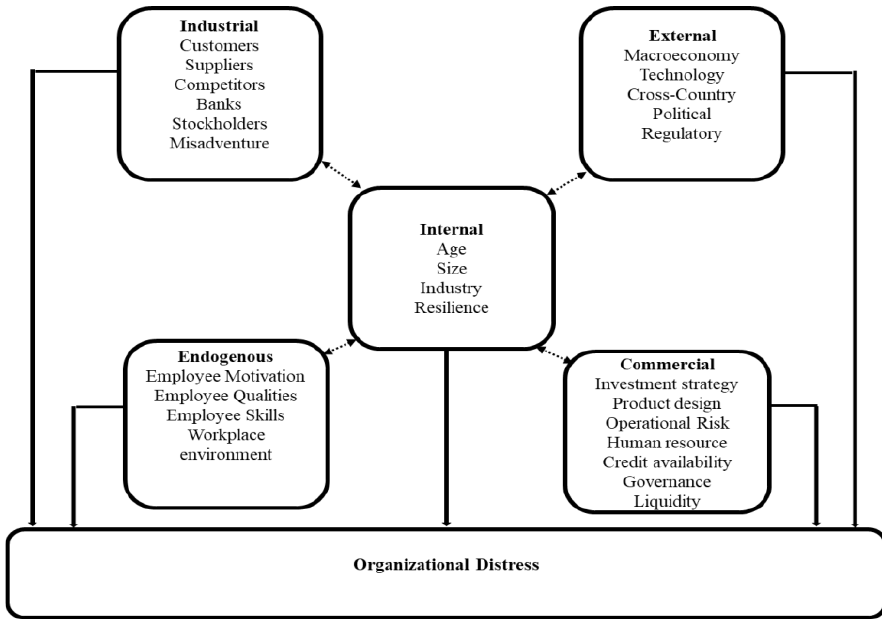
Figure 2: Classification of Distress